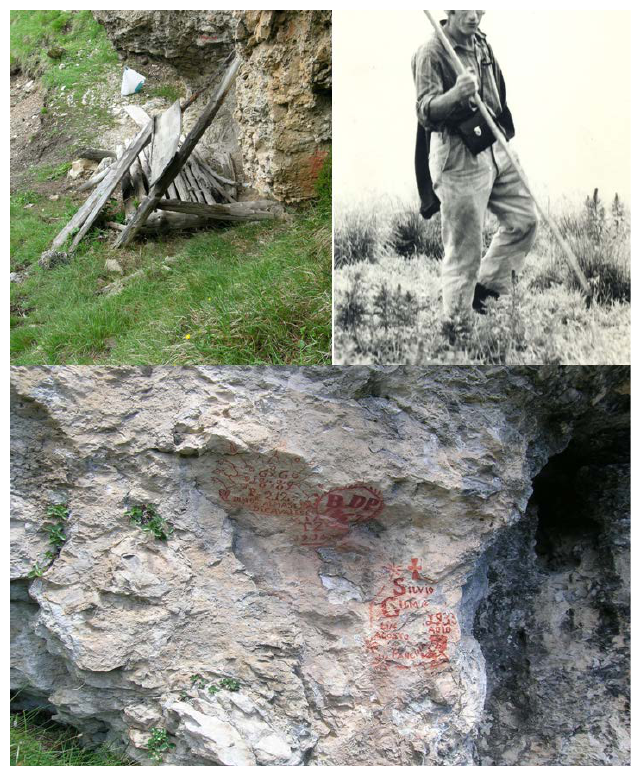
Figure 10 – Ziano di Fiemme – the shelter by the Mandra di Dos Capèl and the shepherd Carlo